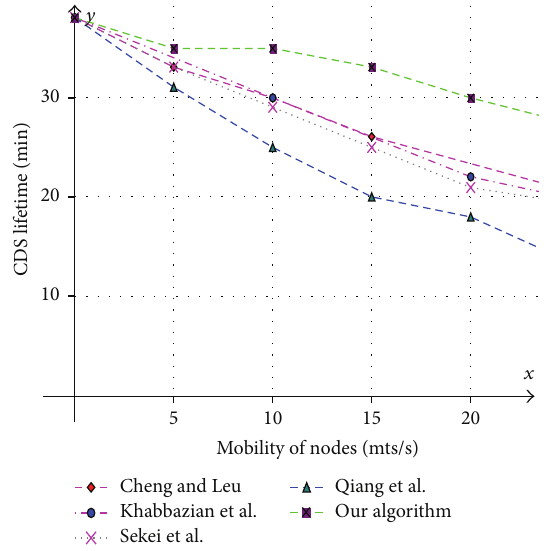
Figure 14: Mobility of nodes (mts/s) versus MCDS lifetime (min).